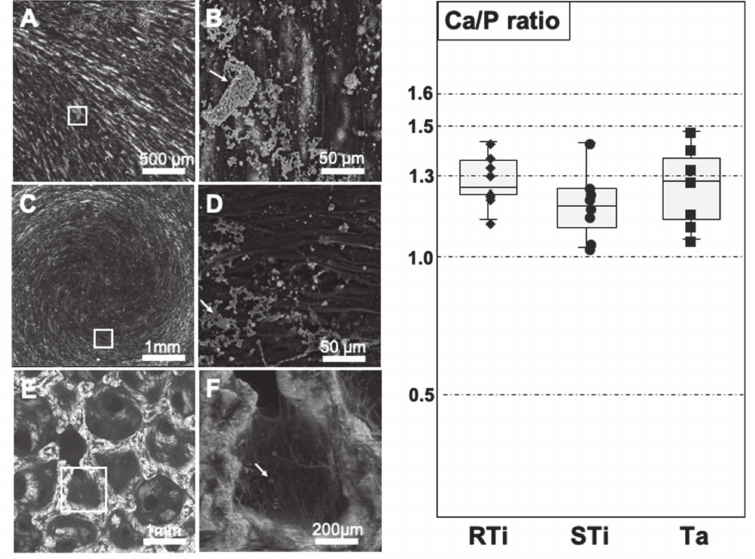
Figure 2. SEM images of DPSC after 3 weeks in osteogenic medium. ( A,B ) RTi at magnification × 100 and × 1500. ( C,D ) STi at magnification × 100 and × 1500. ( E,F ) Ta at magnification × 100 and × 400. White squares on lower magnification images indicate the area of magnification. White arrows indicate calcified nodules. Right graph: box plot representation of Ca / P ratio as calculated after energy dispersive X-ray (EDX) spectroscopy on the various